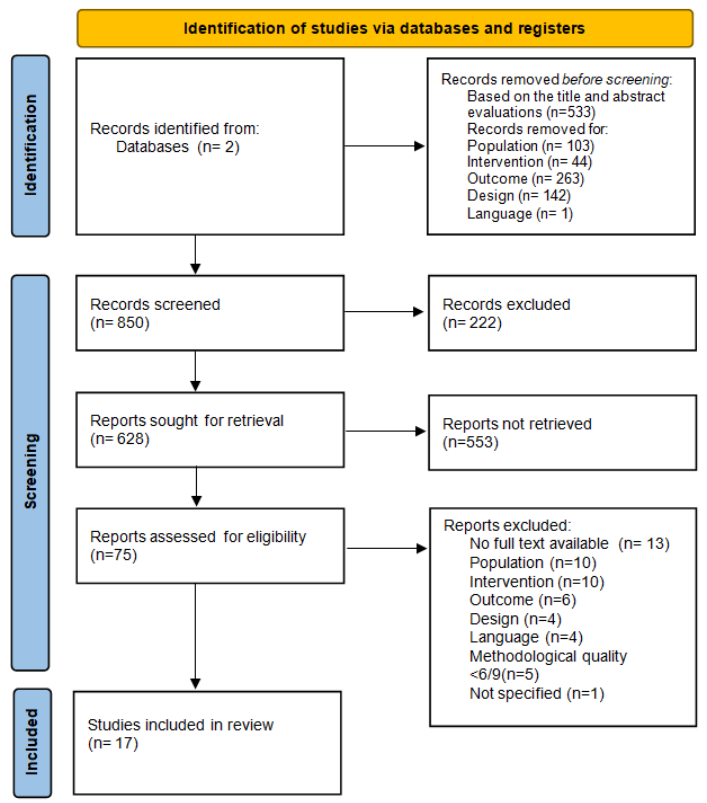
Figure 1. PRISMA screening process for selection of articles for review. Table 2. Methodological assessment using the Newcastle Ottawa quality assessment Scale (NOS).